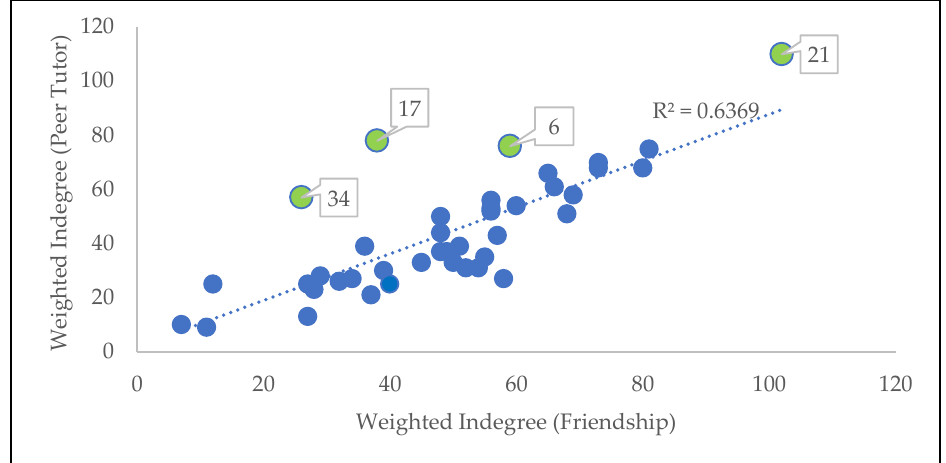
Figure 3. The relationship between weighted indegree of friendship network and weighted indegree of peer tutor networks. The green nodes represent outliers in the scatter plot.